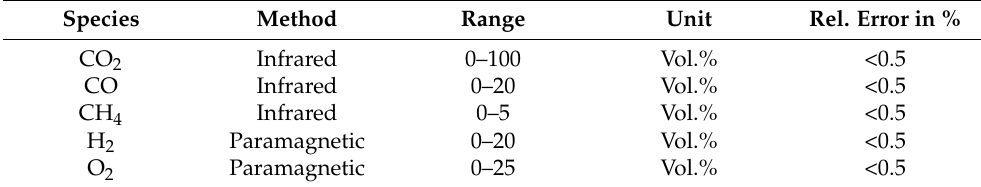
Table 2. The method for continuous measurement of the gas